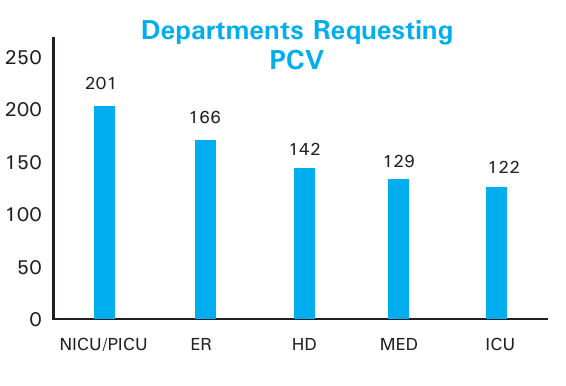
Figure 3. Showing the different clinical departments requesting PCV.